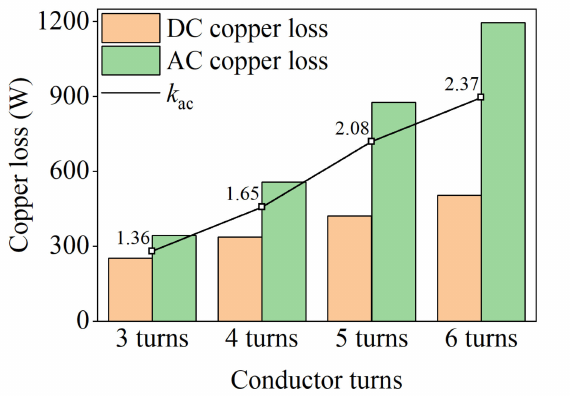
Figure 16. Copper loss and AC/DC copper loss ratio k ac with conductor turns at 1000 Hz.